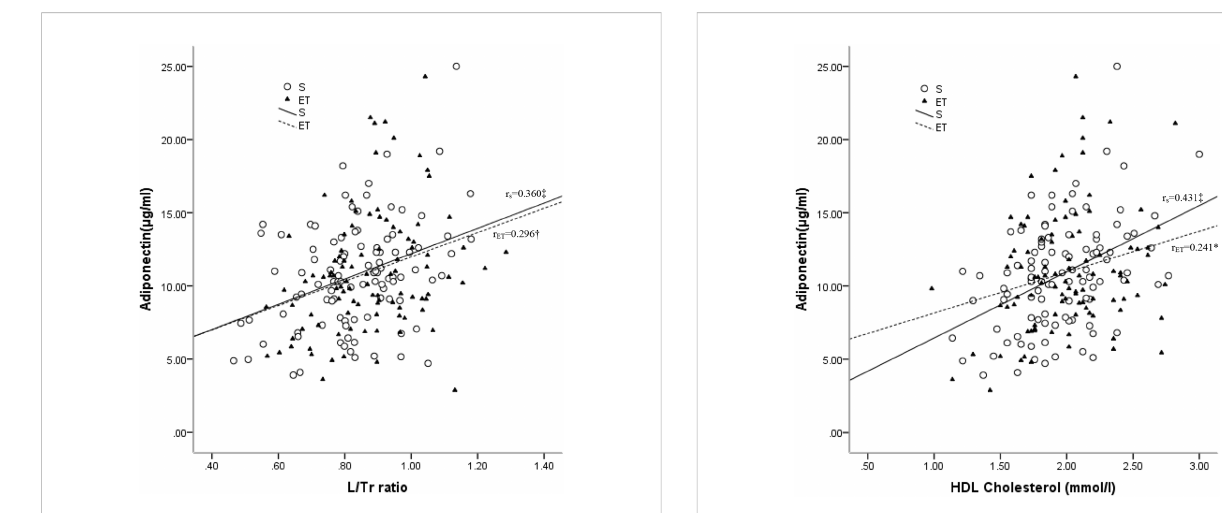
FIGURE 3 Relationships between plasma levels of adiponectin and HDL-C in the sedentary (S) and endurance-trained (ET) groups. R S : correlation coef fi cient of the sedentary group; r ET : correlation coef fi cient of